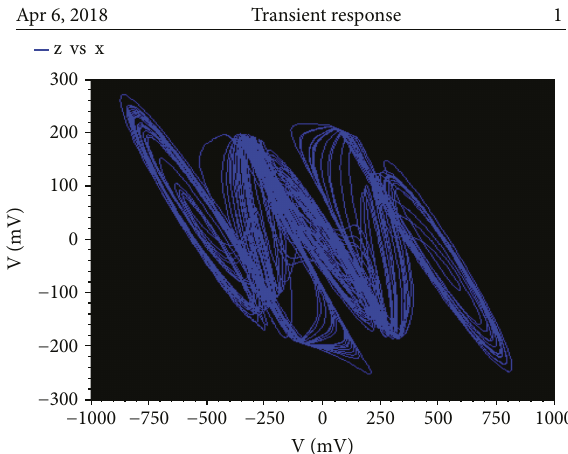
Figure 18: The phase portrait in the x - z plane (S on, S is turned o ff ). 2 1